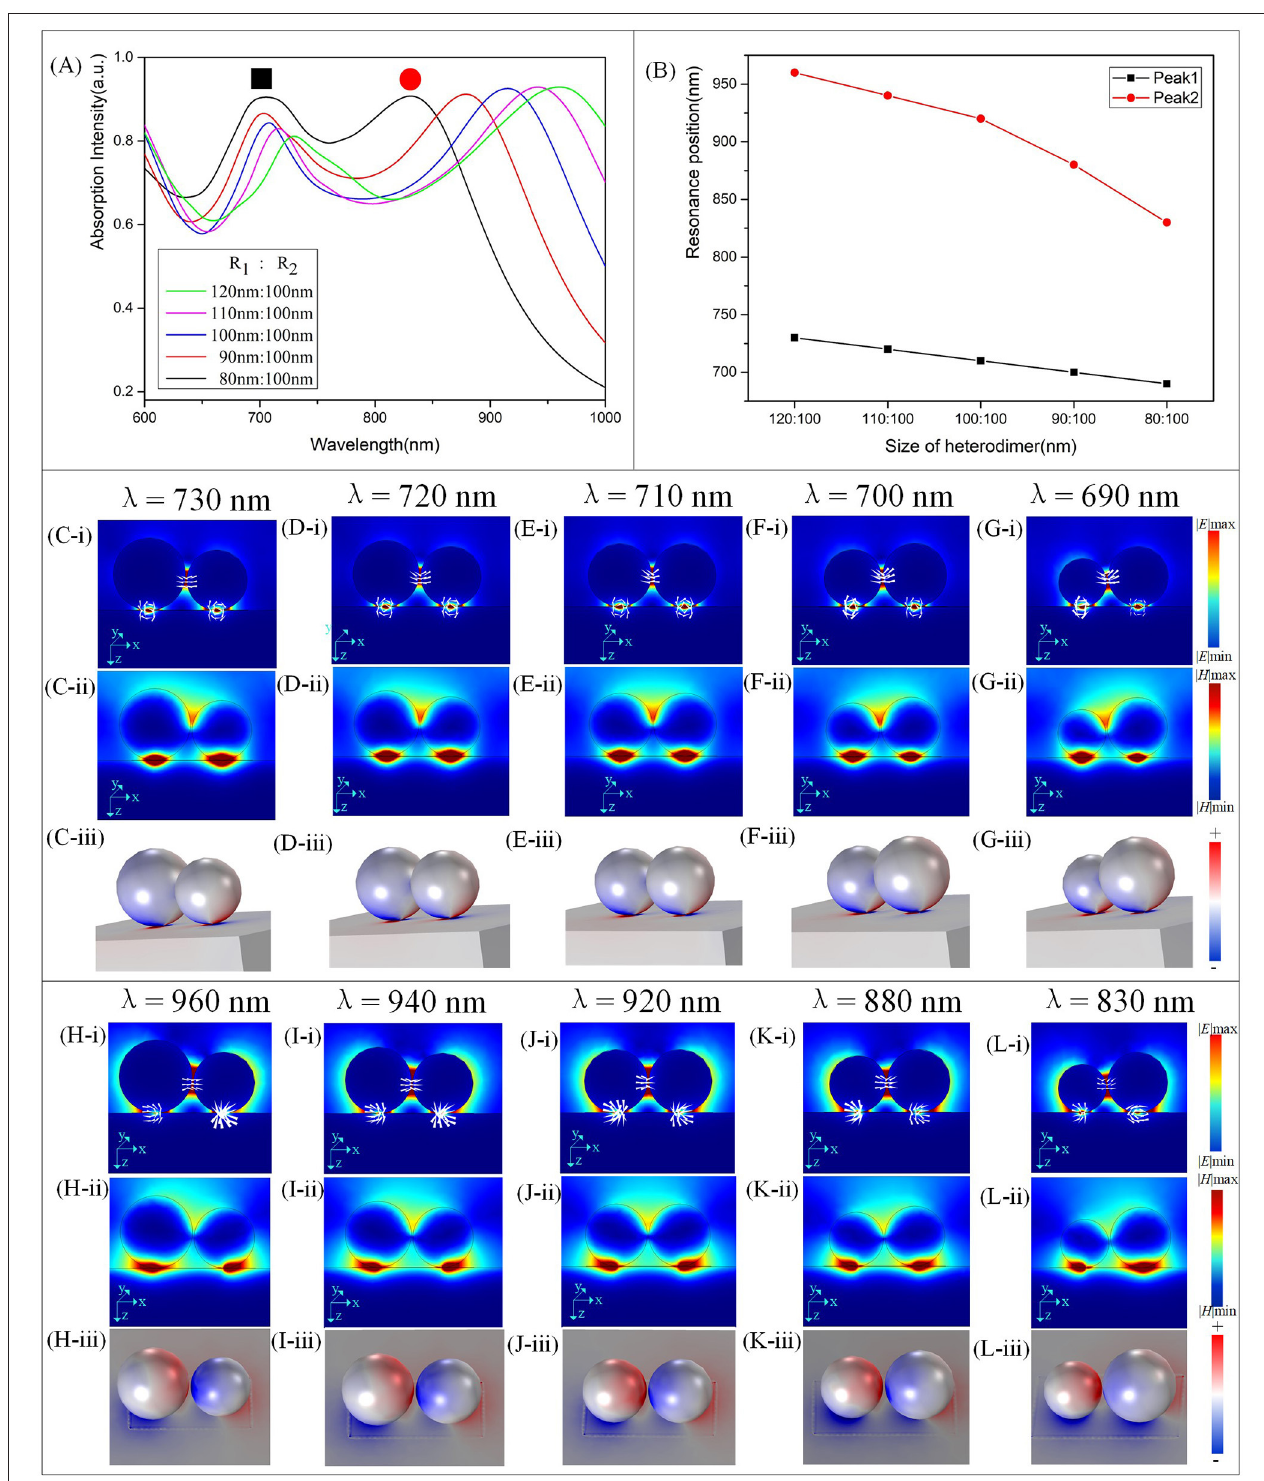
FIGURE 2 | (A) Absorption spectra of Au nanosphere dimer–dielectric–Au film nanostructures with R 1 varied from 120 to 80nm, while R 2 is fixed at 100nm. Peak 1 (black square) and Peak 2 (red circle) are marked in the absorption spectrum. (B) The resonance peaks as a function of the nanosphere dimer size. (C–G) Distribution of the electric field (i), the magnetic field (ii), and the surface charge (iii) at Peak 1 corresponding to the nanosphere dimer with R 1 from 120 to 80nm. (H–L) Distribution of the electric field (i), the magnetic field (ii), and the surface charge (iii) at Peak 2 corresponding to the nanosphere dimer with R 1 from 120 to 80nm.